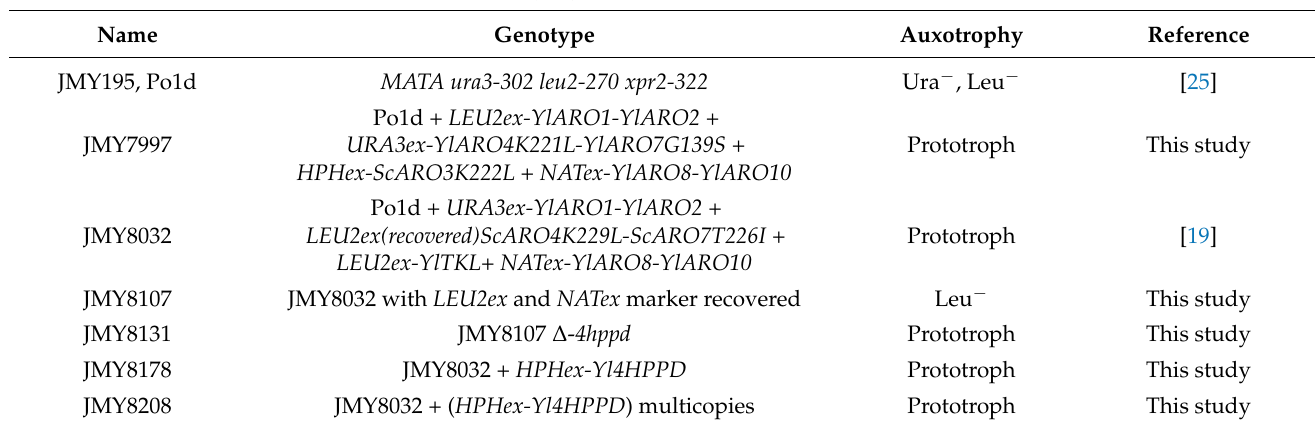
Table 1. YlARO4K221L and YlARO7G139S are both the mutated forms of Y. lipolytica Aro4 and Aro7, corresponding to the feedback-inhibited counterpart of the S. cerevisiae enzymes; ScARO3K222L, ScARO4K229L, and ScARO7T226I correspond to the feedback inhibited mutant of S. cerevisiae enzyme ScAro3, ScAro4, and ScAro7 [19]. Yarrowia lipolytica Strains Used in This